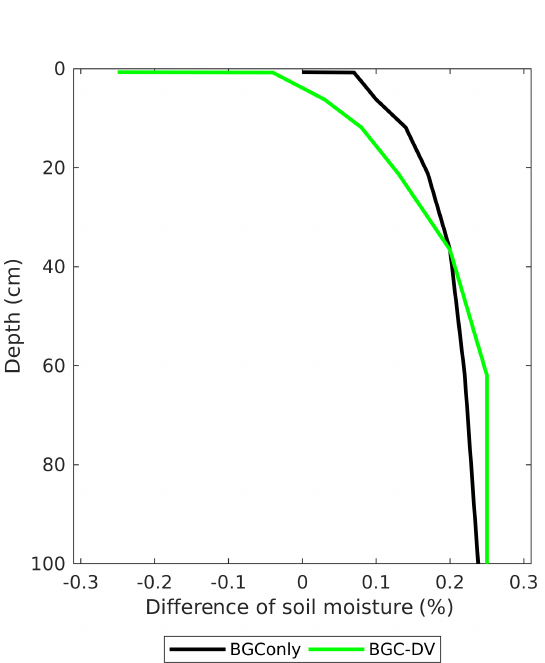
Figure 9. Difference in soil moisture (%) due to fire in BGConly (i.e., BGConly-F minus BGConly-NF) and BGC-DV (i.e., BGC- DV-F minus